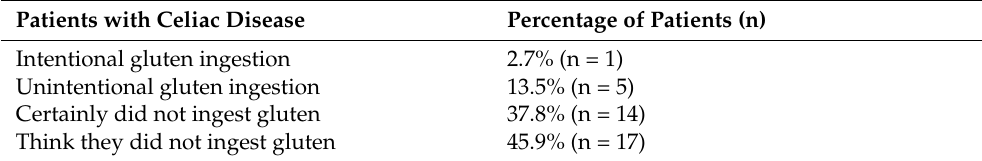
Table 1. Reported consumption of gluten by children with celiac disease since the start of the COVID-19